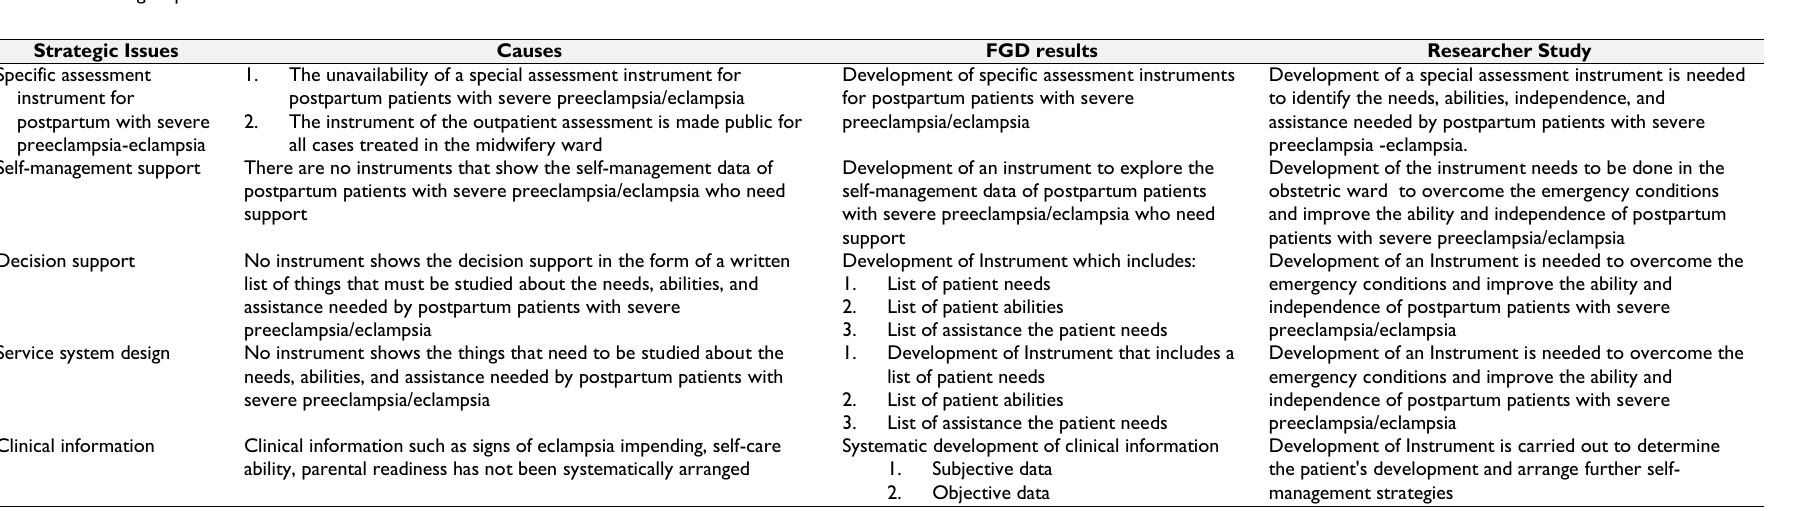
Table 2 First focus group discussion